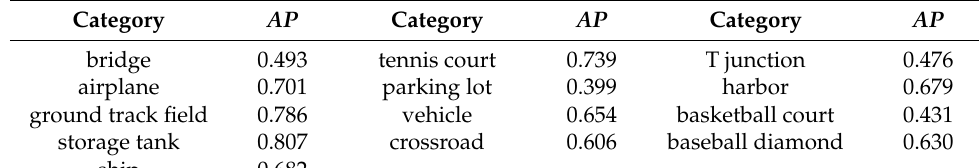
Table 7. The AP s of different categories by EFNet on the dataset HRRSD.